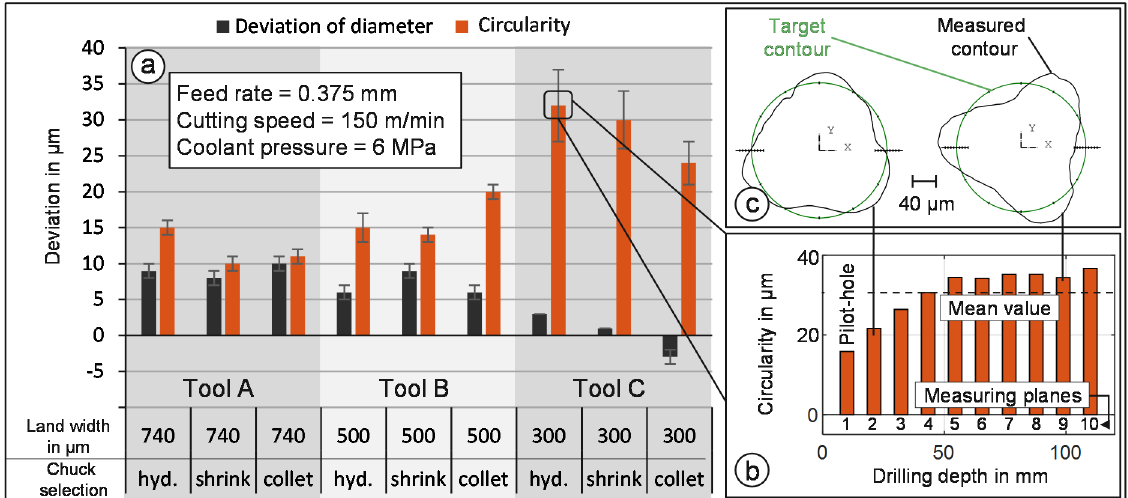
Figure 4. Results of the first investigation: ( a ) the mean value from 10 measuring planes and 27 holes, ( b ) the mean value from 27 holes along the measuring planes, and ( c ) the exemplary circularities at two different drilling depths.